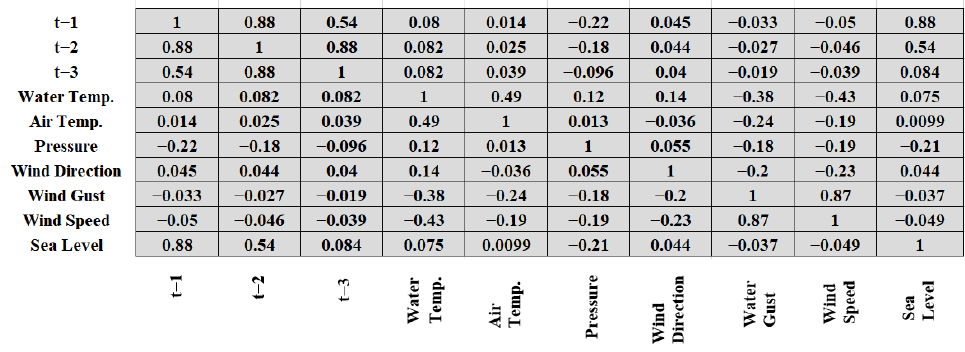
Figure 3. Correlation matrix showing sea level correlation with its lags and associated oceanic parameters. Table 2. Input features and description.